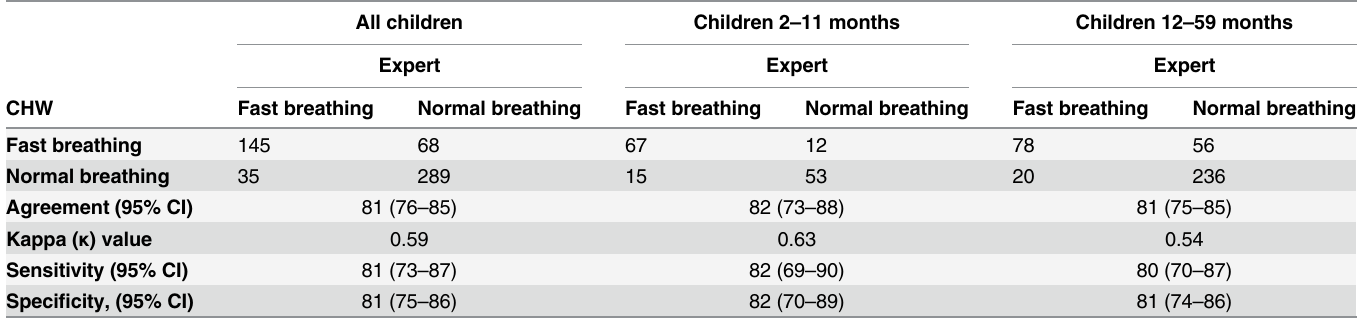
Table 2. CHW classification of fast and normal breathing compared to expert